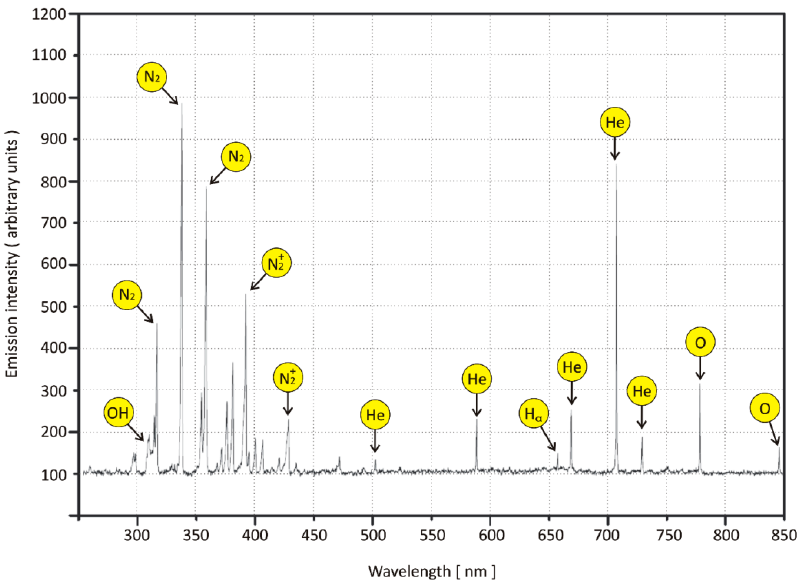
Figure 4. Plasma emission spectrum for our 50 mm wide cold plasma applicator, working in pure helium, for an input power of 50 W.